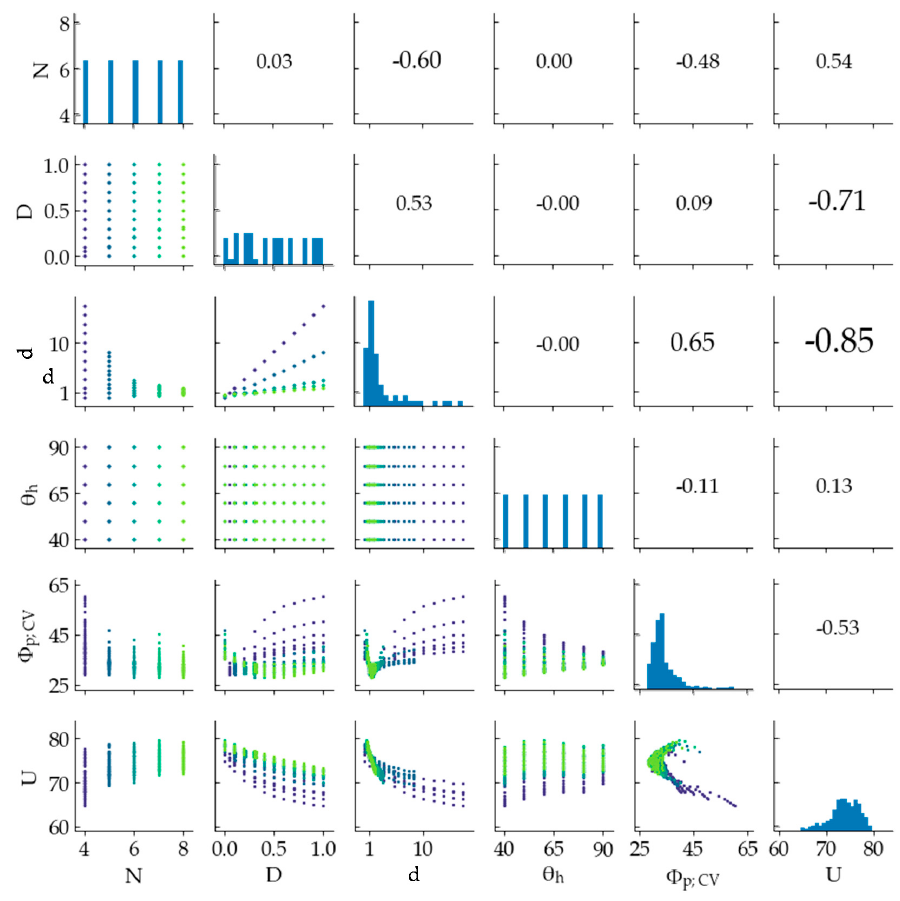
Figure 11. The scatter plot matrix of the 3 lighting design variables, the number (N), distance (D and d), and light distribution ( θ h , ◦ ) of the BRLED lamps, and 2 evaluation indexes, the coe ffi cient of variation of the light absorption of individual plants ( Φ p; CV , %) and the coe ffi cient of utilization for the lighting system (U, %). The first 4 rows and columns are the lighting design variables, and the last 2 rows and columns are the evaluation indexes. The upper triangular matrix of the scatter plot matrix contains the coe ffi cients of correlation for each two element combination, and the font size is proportional to the coe ffi cients of correlation. The diagonal matrix of the scatter-plot matrix contains the histograms for each element. The lower triangular matrix of the scatter plot matrix contains the scatter plots for each two element combination. The plots were color-coded according to N